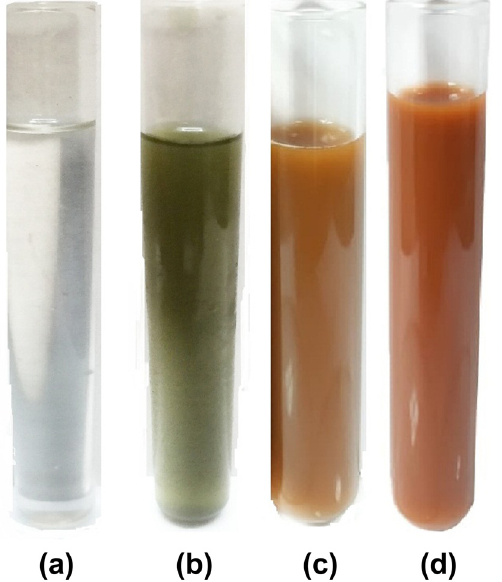
Figure 1: Visual observations of Na 2 SeO 3 ( 10 mM ) solution ( a ) , Spirulina platensis cell - free extract ( b ) , initial reaction of Na 2 SeO 3 with the extract ( c ) , and Spirulina - selenium nanoparticles ( Sp SeNPs ) after synthesis completion ( d )